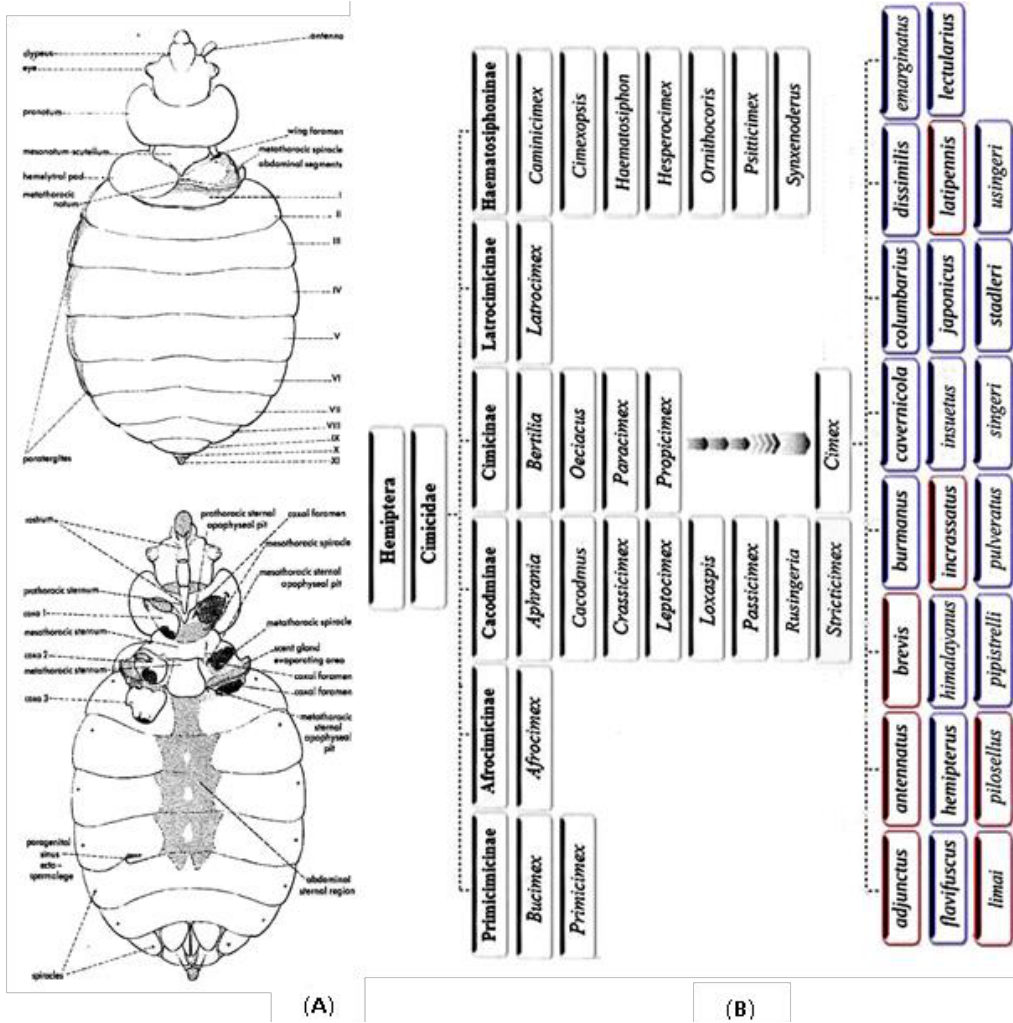
Figure 3. Panel ( A ) Morphological characteristics of bed bugs ( C. lectularius ), panel ( B ) Suggested updated classification of Cimex species. Species highlighted in blue and red have been likely originated/reported in the Old and New world,